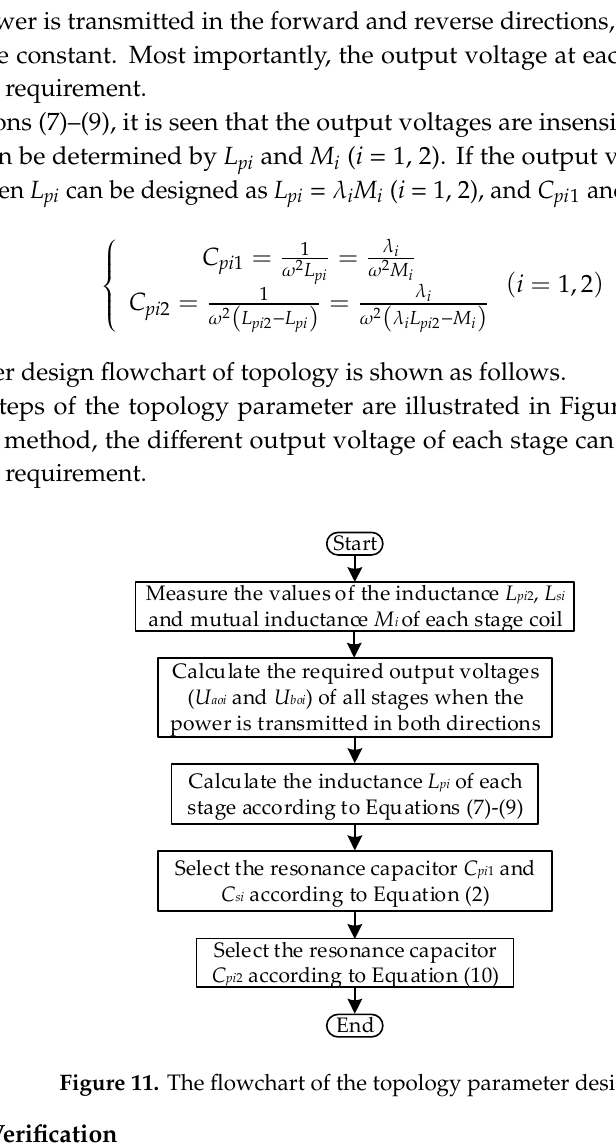
Figure 12. Experimental setup.